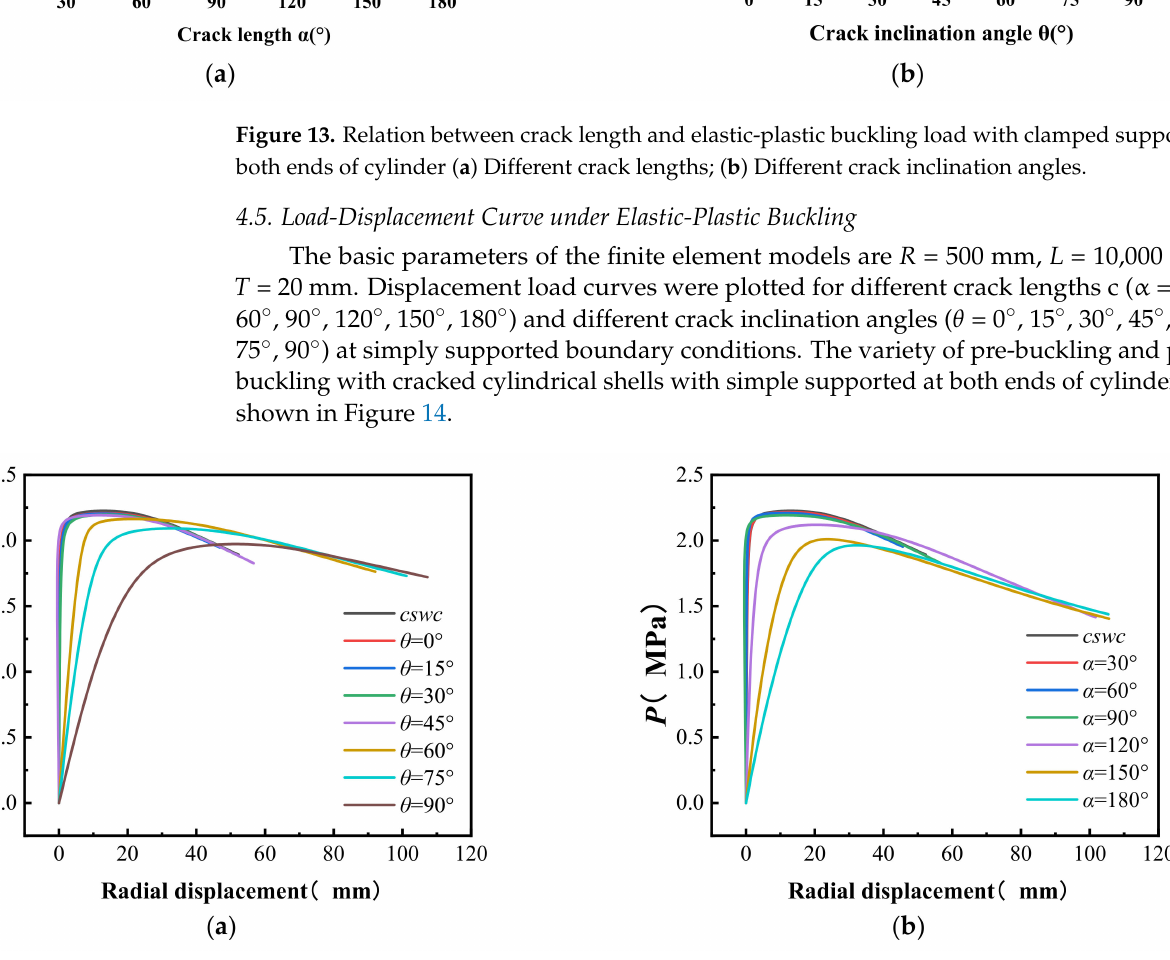
Figure 14. Load-displacement curves ( a ) Different crack inclination angles ( α = 90 ◦ ); ( b ) Different crack lengths ( θ = 45 ◦